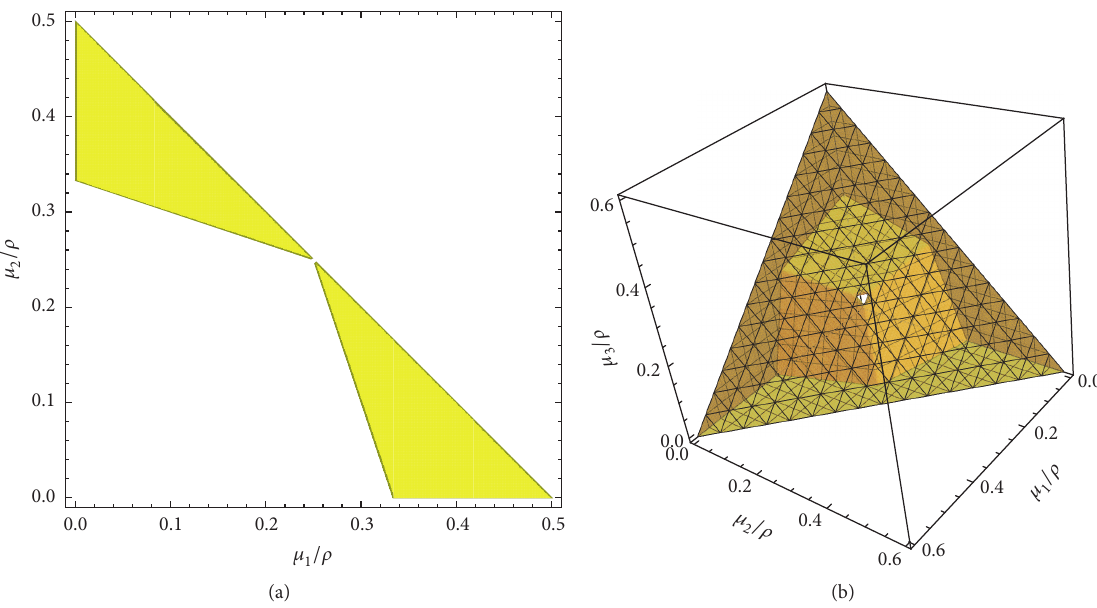
Figure 10: (a) Set difference D ( T −1 𝜌 ) \ D (𝜏 −1 𝜌 ) in V = 2 dimensions. (b) Set difference D ( T −1 𝜌 ) \ D (𝜏 −1 𝜌 ) in V = 3